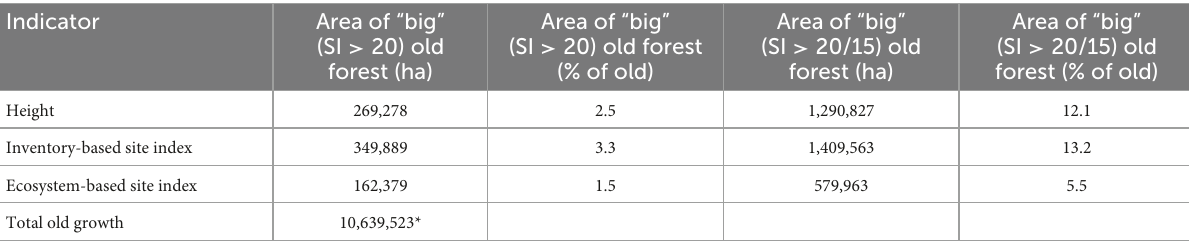
TABLE 3 Area of “big-treed” old growth in BC using equivalent thresholds for three indicators calibrated to improve